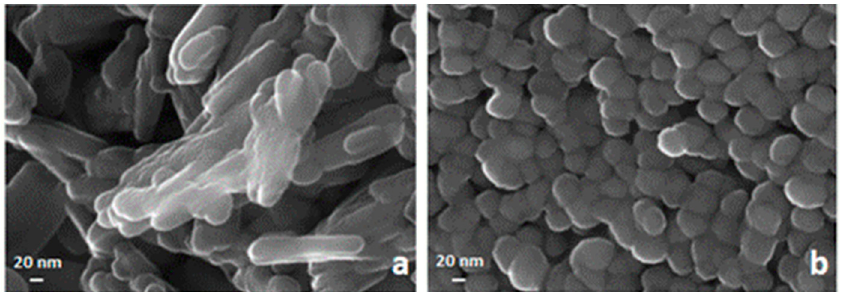
Figure 4. FE-SEM images of a nanosized solid phase obtained by calcination at 400 °C of Fe(OH) 3 synthesized by precipitation with NaOH ( a ) and by precipitation with NH 4 OH ( b ).